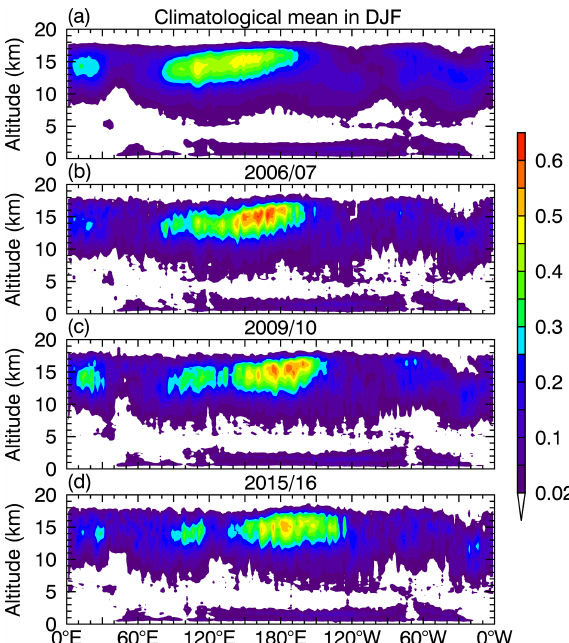
Figure 11. Distribution of cloud occurrence between 0 ◦ N and 15 ◦ N in (a) all winters and the (b) 2006/07, (c) 2009/10, and (d) 2015/16 winters derived from CALIPSO from June 2006 to De- cember